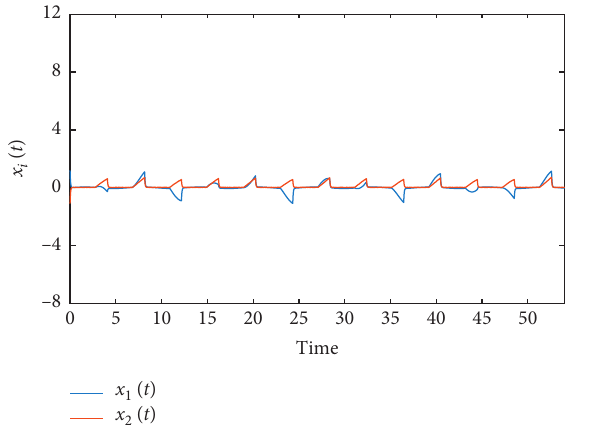
Figure 1: State trajectories x observer-based T-APIC.